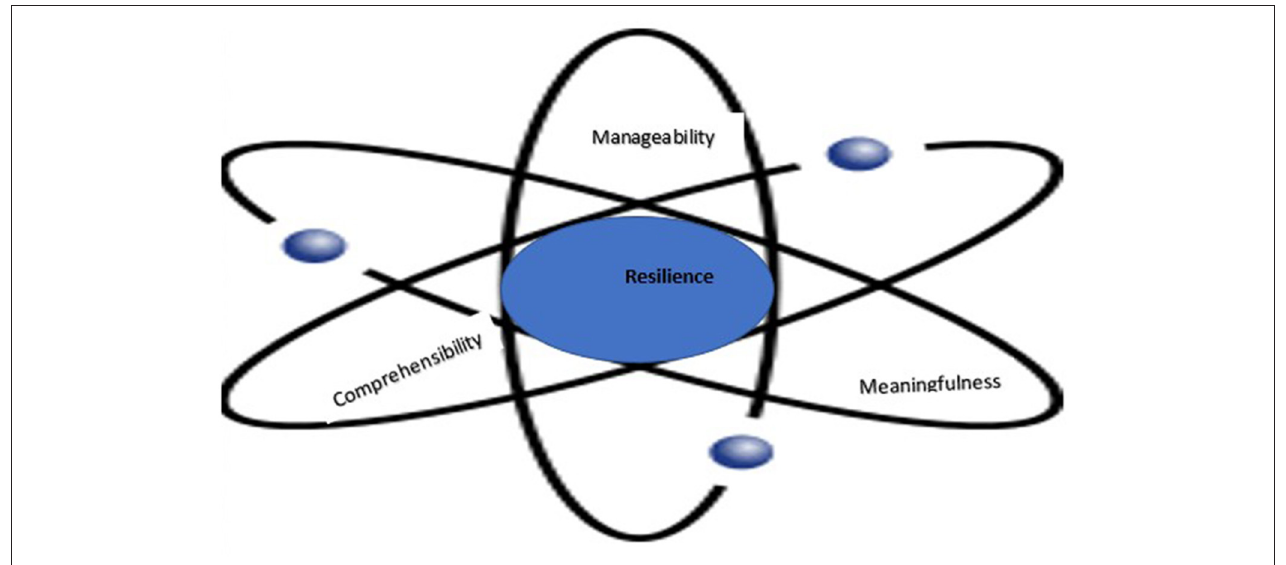
FIGURE 4 | The dynamic spheres of resilience